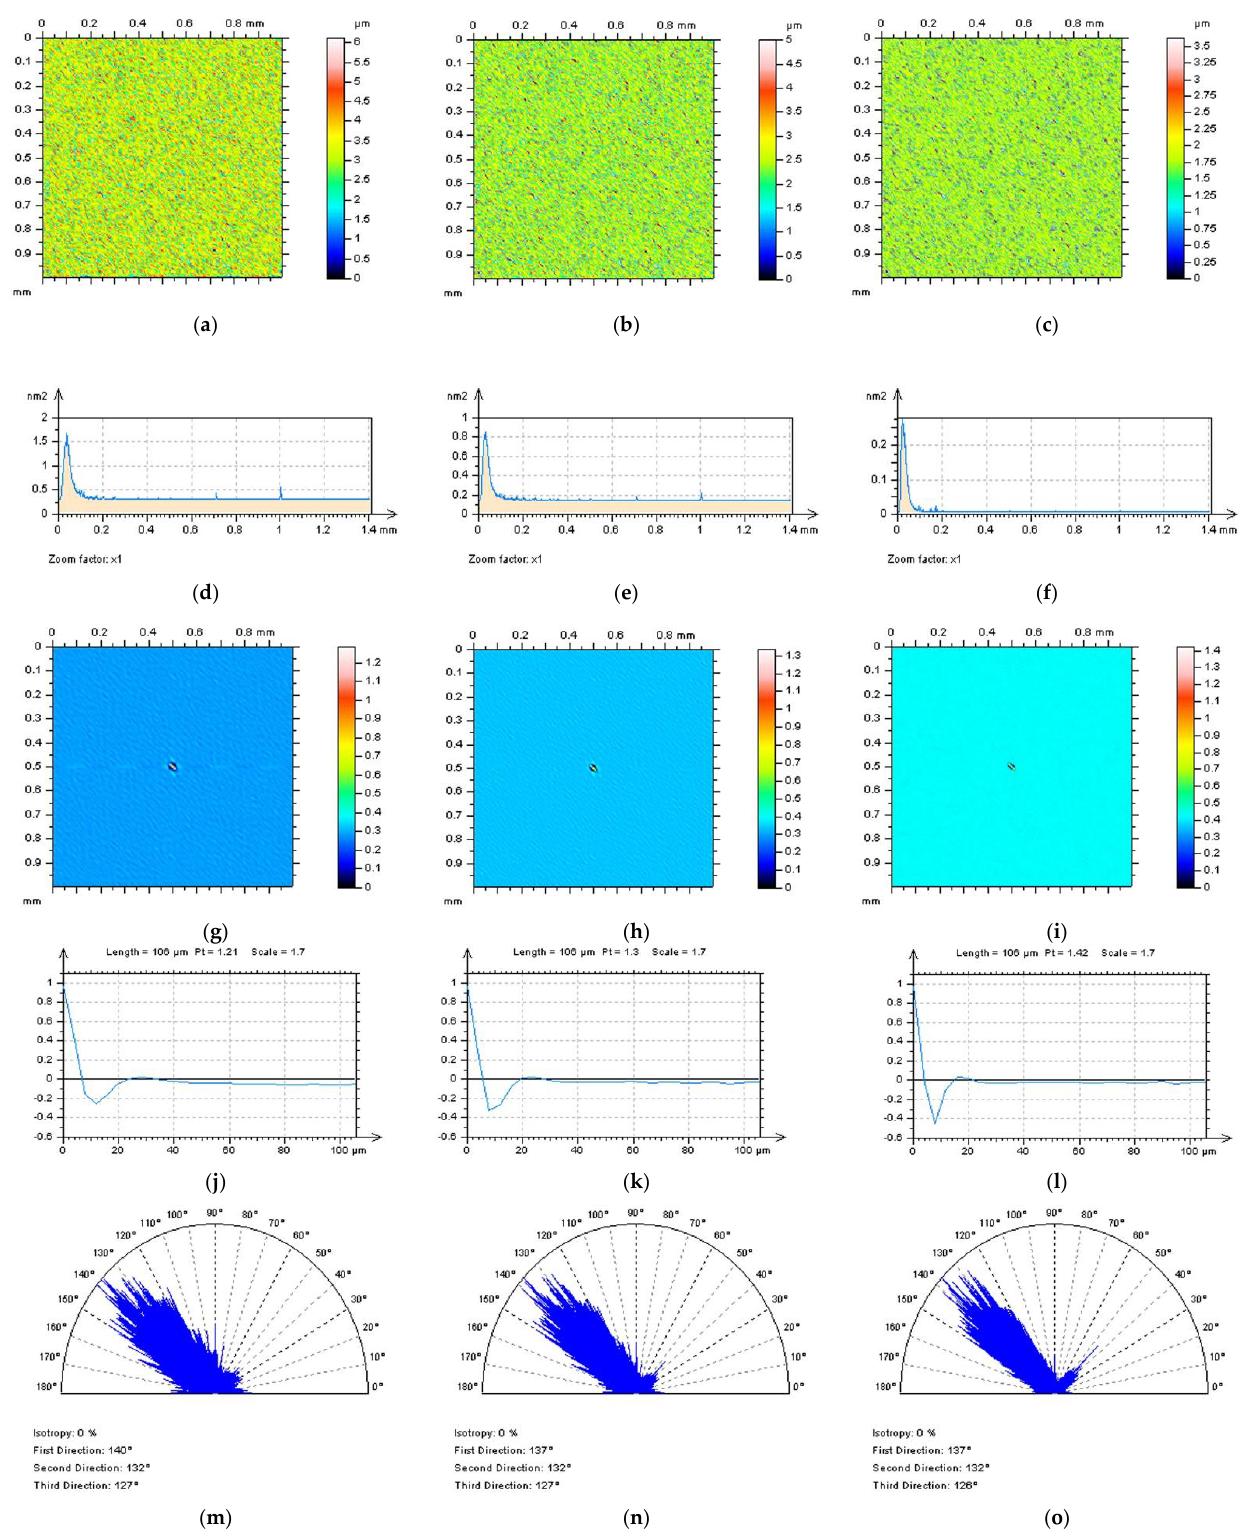
Figure 9. Contour map plots ( a – c ), its 3D PSDs ( d − f ), 3D ( g − i ), and 2D ( j − l ) ACFs and TDs ( m − o ) received from NSs defined by an application of SF with cut-off equal to: 0.035 mm (left column), 0.025 mm (middle), and 0.015 mm (right column), obtained for surface D. Validation of the method (filter) should be improved for surfaces containing certain features, such as surface B. In this case, the surface contains one valley feature. It is sug- gested to observe the area on the NS where this feature is located. In Figure 10, it NSs can be observed when an FFTF is applied for various bandwidth values, e.g., 0.035 mm, 0.025 mm, and 0.015 mm. For all three values, the isometric view of the NSs and PSD graphs do not indicate non-noise features, especially in the location where the feature occurred. However, both NSs, defined at 0.035 mm and 0.025 mm bandwidth values, were not iso- tropic. This indicates that some features of the surface have their own directions. On the other hand, the direction can indicate feature occurrence; therefore, the TD graph can in- dicate falsely estimated NSs (filter or its cut-off value) even though non-noise features are recognisable.